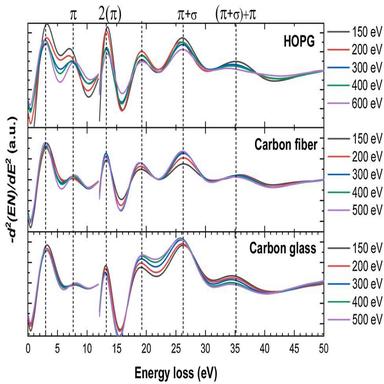
Negative second-order differentiation of REELS of HOPG, carbon fiber and carbon glass.